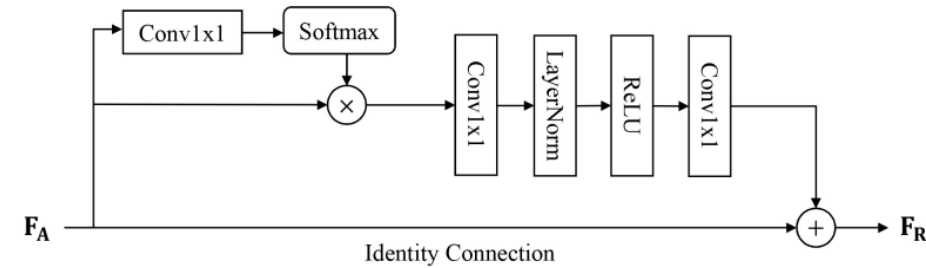
Figure 5. Structure of the fine-grained tuning